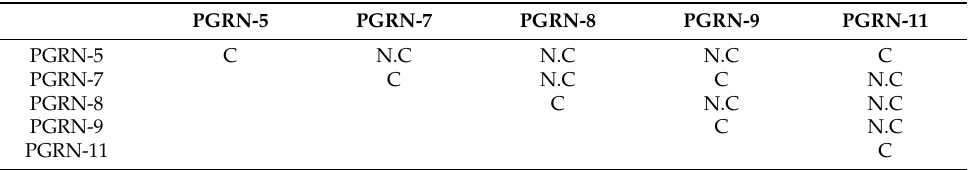
Table 4. Non-competitive Nb pair possibilities for PGRN (C—competitive; P.C—partially competitive;